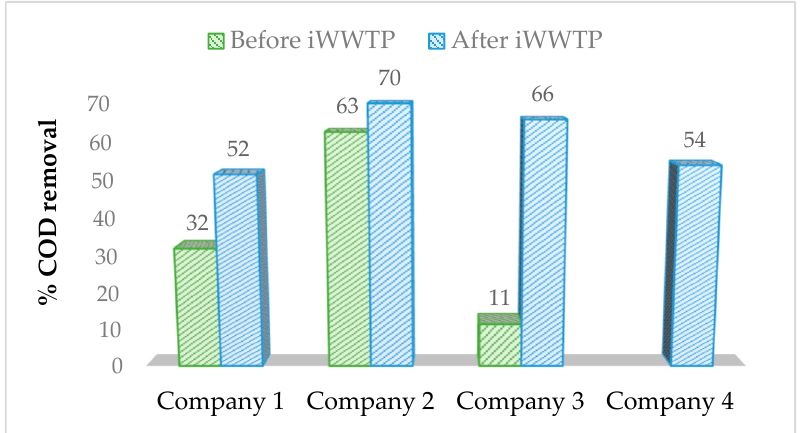
Figure 6. % Fat removal before and after the iWWTP.